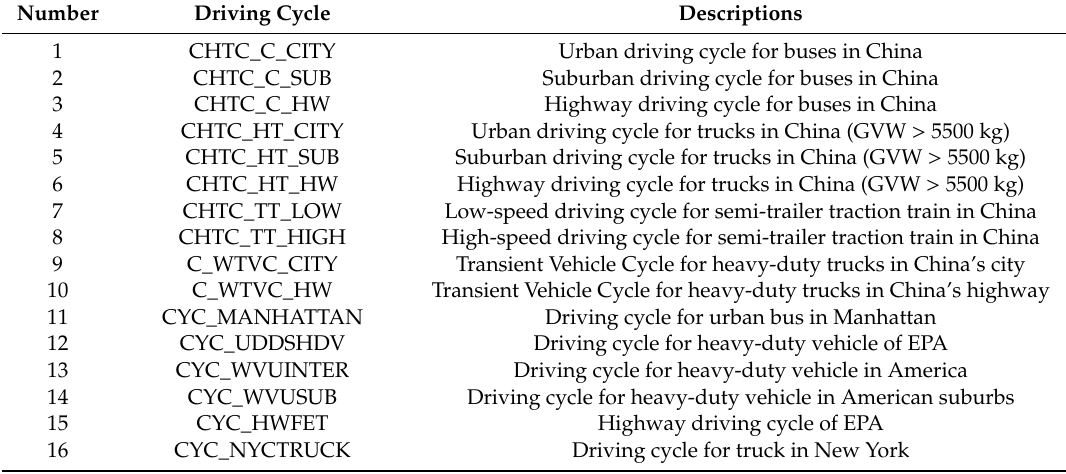
Table 3. Updated sample database of driving cycles for hybrid heavy-duty